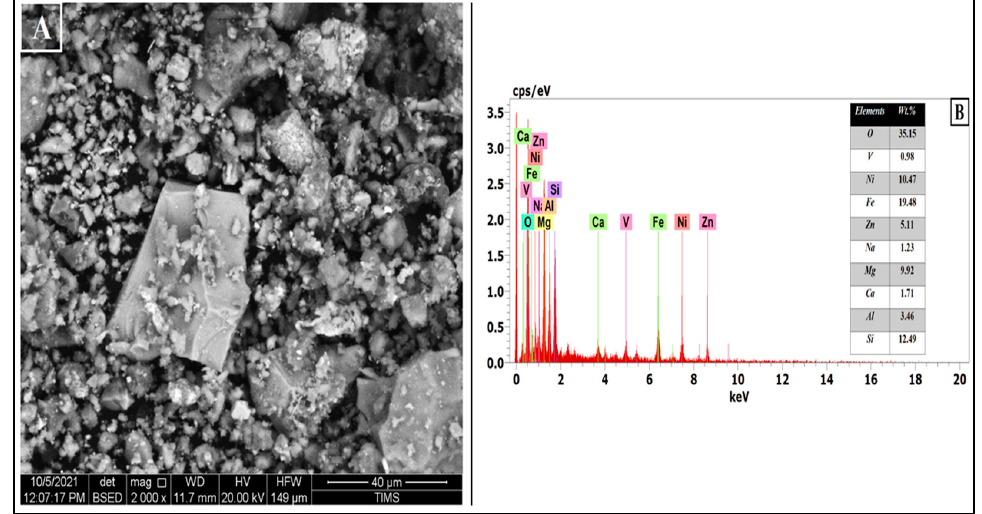
Figure 2. SEM images of used water leaching solid residue (WLSR) obtained under optimum leaching conditions of the Egyptian boiler ash ( A ) and EDX element analysis ( B ).